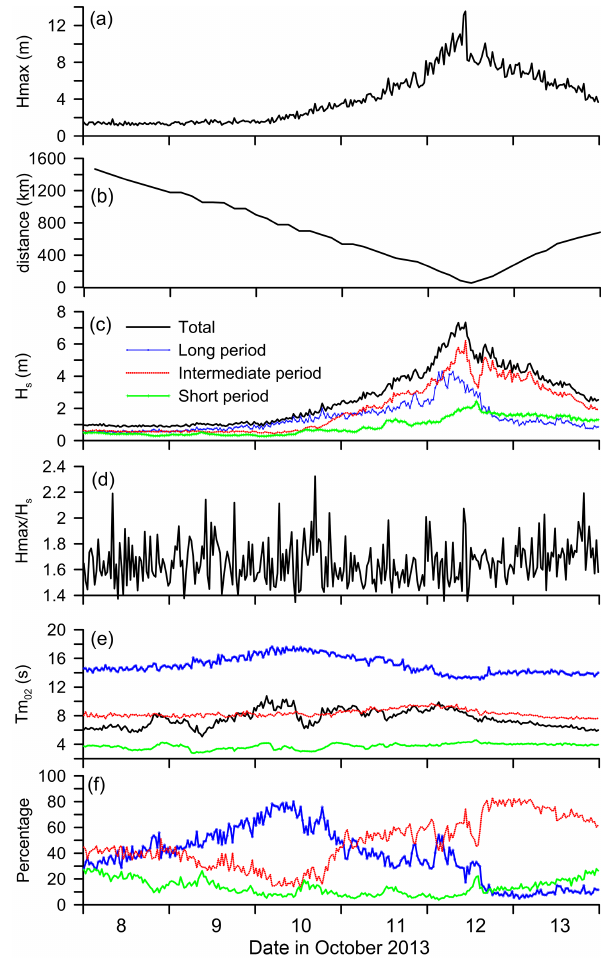
Figure 3. Variation of (a) maximum wave height, (b) distance of the cyclone from the buoy location, (c) significant wave height of long, intermediate and short period waves, (d) ratio of maximum wave height to significant wave height, (e) mean wave period of long, intermediate and short period waves and (f) percentage of long, in- termediate and short period waves during 8–13 October 2013.